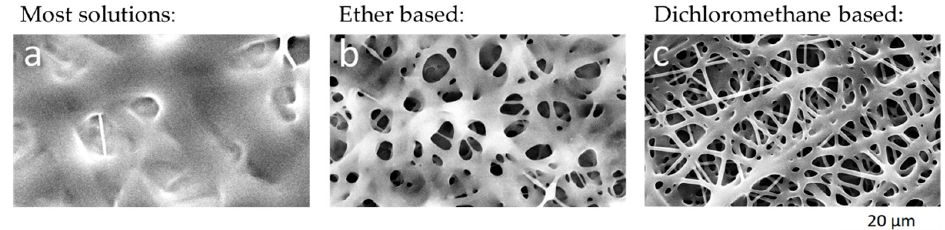
Figure 1. Electrospinning P(3HO- co -3HD) with ethyl acetate ( a ). Solutions based on green solvents (such as ethyl acetate, butyl acetate, dimethyl carbonate, methyl ethyl ketone) mostly result in bad quality fiber depositions with the nanofibers being fused together. Fast evaporating solvents such as diethyl ether result in porous membranes ( b ), but still the porosity is reduced. Fast evaporating halogenated solvents such as dichloromethane ( c ) and chloroform result in a porous nanofiber structure.